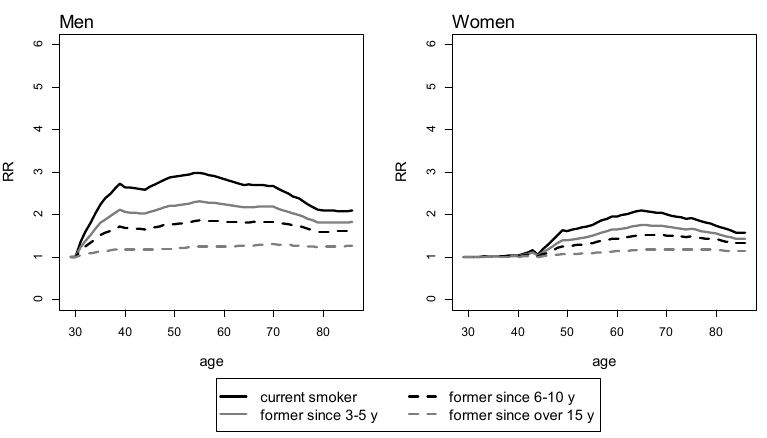
Figure 2. Relative risks of death for current and former smokers who smoked 10–19 cig/day by number of years since quitting smoking and sex.